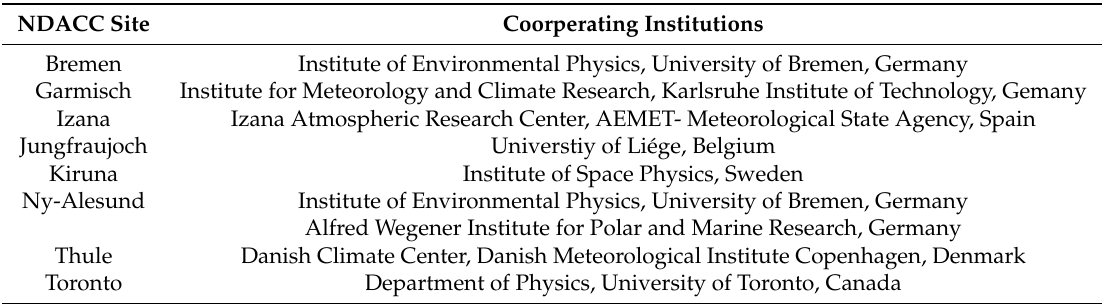
Table A1. NDACC sites used in this publication and the coorperating institutions.